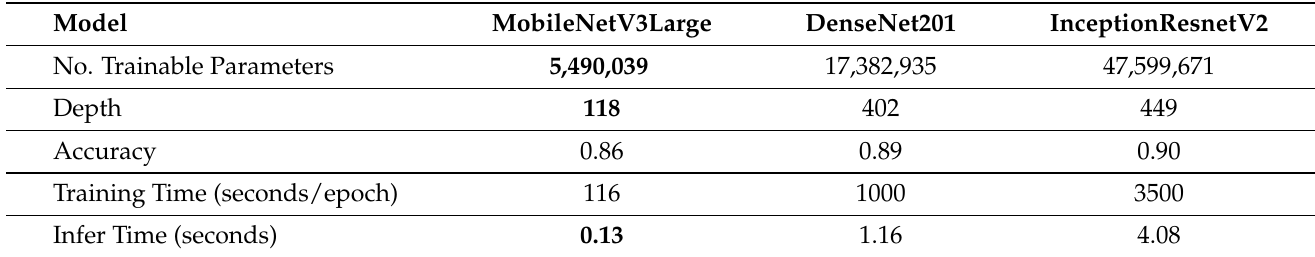
Table 6. Comparison between MobileNetV3Large with DenseNet201 and InceptionResNetV2.